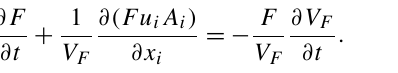
Figure 8. Comparison of wave height damping ratio between sta- tionary and moving